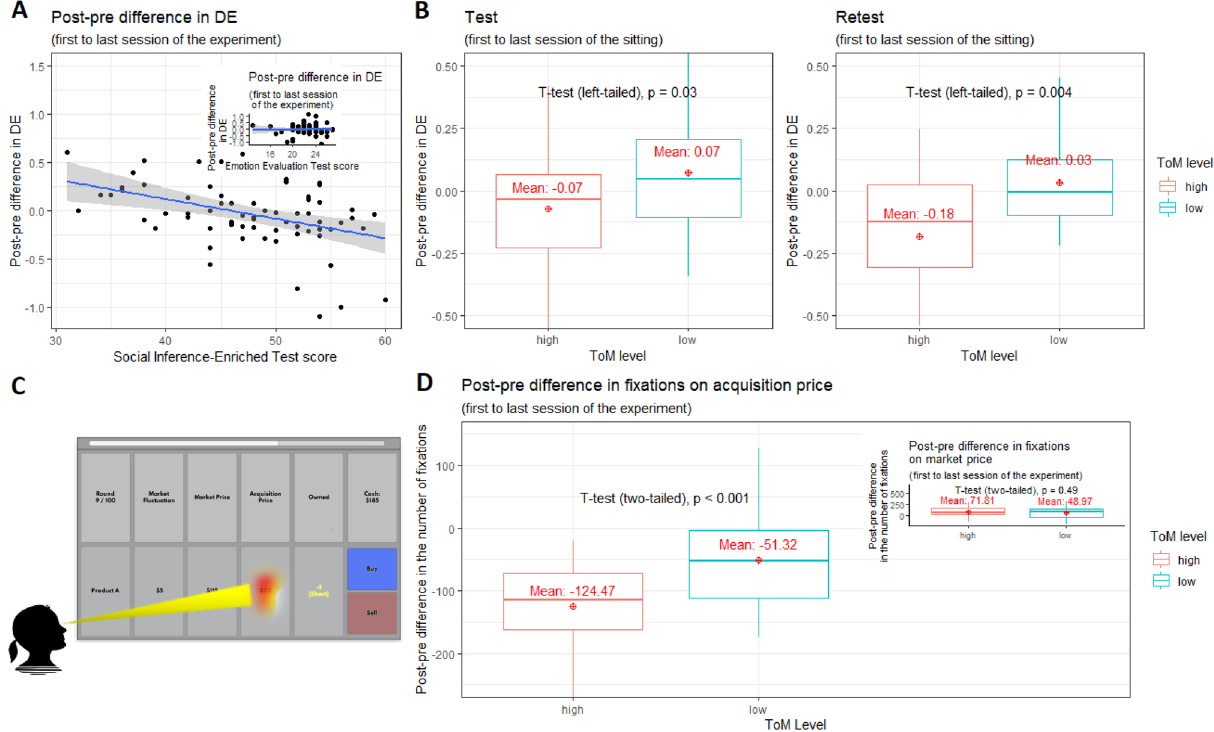
Figure 2. ( A ) The results of OLS regression analyses where Social Inference-Enriched (SI-E) test score (and Emotion Evaluation Test (EET) score in the inset) is used as a predictor of the change in disposition effect, calculated as post-pre difference in disposition effect, reveal that Disposition Effect (DE) decreases significantly from session I of first sitting to session IV of second sitting, as a function of score on the Social Inference- Enriched (SI-E) test score. (Inset: For comparison, DE does not change as a function of the Emotion Evaluation Test (EET) score). ( B ) Boxplots of changes in DE for two cohorts based on median split of average SI-E scores (forms A and B), during test sitting (Left) and retest sitting (Right). ( C ) Display of game interface, featuring Round, Market Fluctuation since previous round, Market Price in current round, Acquisition Price, indication whether stock is Owned ( + 1 ) or sold short ( − 1 ), Cash still available in round, and two choice panels (Buy or Sell; if position is long (+1), Buy is unavailable and hence grayed out; if position is short (-1), Sell is unavailable and hence grayed out). Here, participant’s eye fixation is on Acquisition Price panel. ( D ) Boxplots of post-pre differences in number of fixations on acquisition price panel relative to total number of fixations, from the last session (IV) to the first session (I) of the experiment, stratified by social-cognitive ToM score (Inset: for comparison, post-pre differences in fixations on market price panel, from last (IV) to first session (I) of the